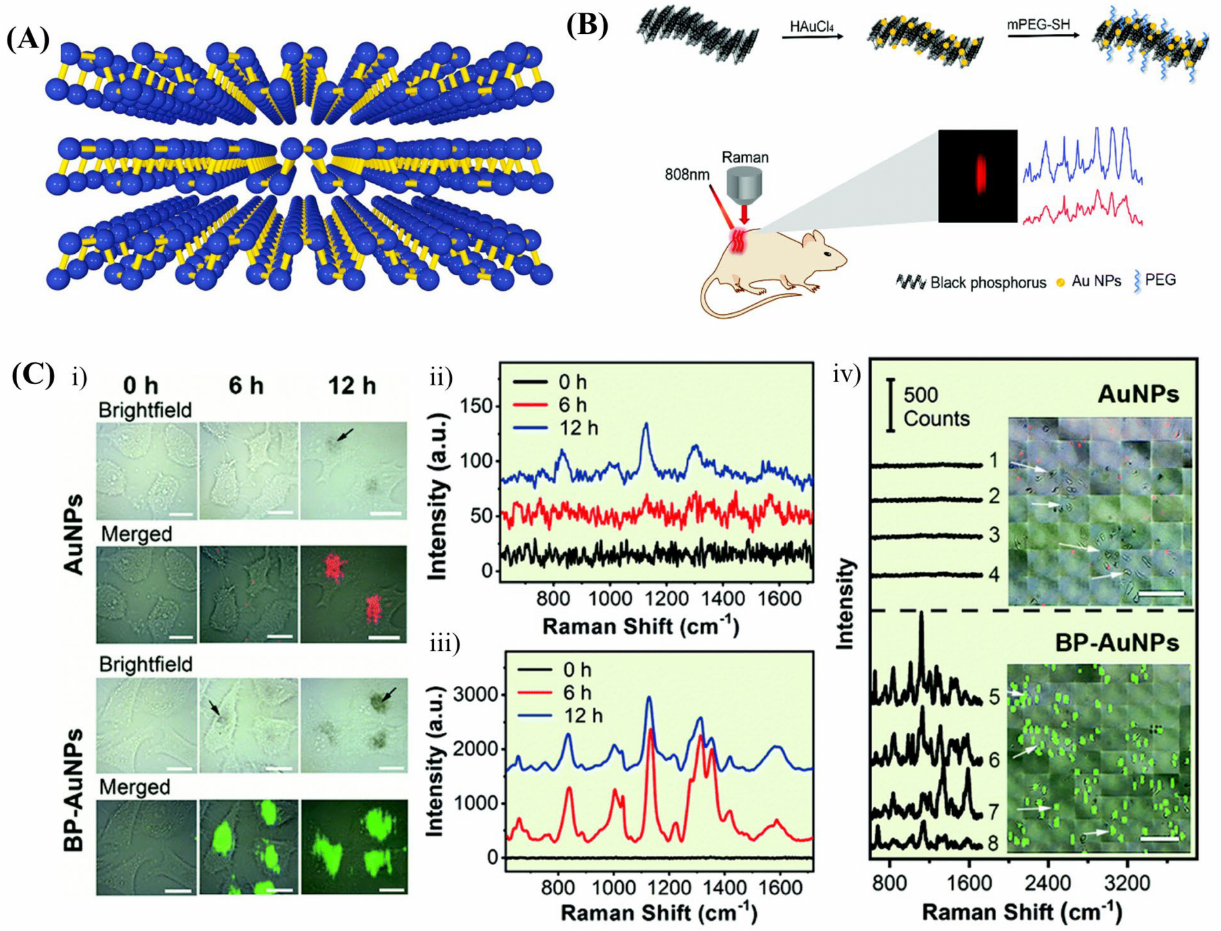
Figure 5. ( A ) Layered structure of Black Phosphorous [158]. ( B ) Schematic illustration of